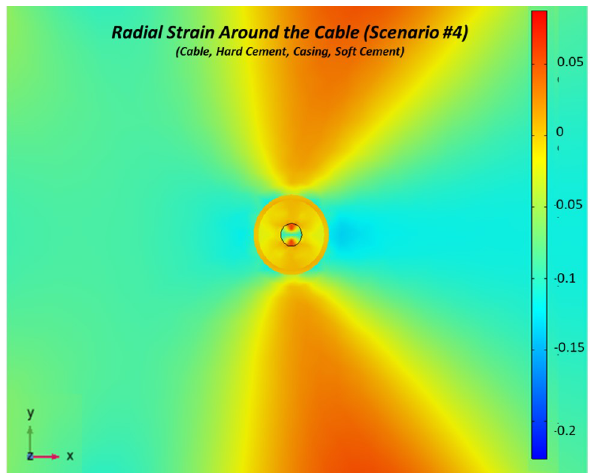
Figure 8. Radial strain around the cable as a response of compres- sional wave propagation at a 90 ◦ incident angle in scenario 4 (inci- dent waveform is incoming from the right).